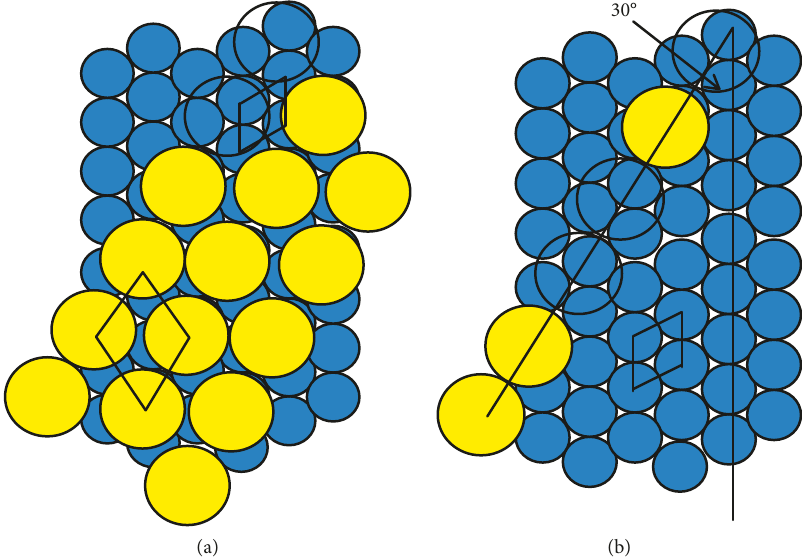
Figure 2: Model of the ( √ 3 × √ 3) R 30 ° structure: (a) high coverage structure; (b) 30 ° angle between S and Pd unit cells main directions. Yellow and blue circles represent sulfur and palladium atoms, respectively.